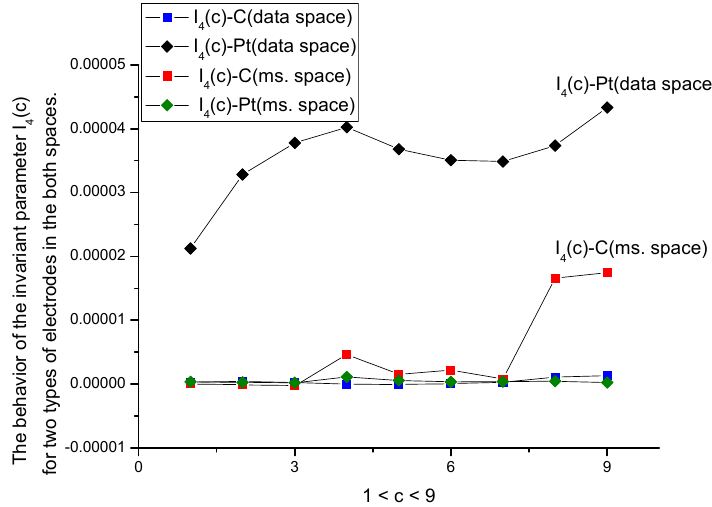
Figure 8. Behavior of the parameter I 4 ( c ) from Equation (A17). Having small values located in the interval 10 − 6 to 5 × 10 − 5 , it has a maximal sensitivity to the presence of an uncontrollable factor that can influence the interaction between the chosen electrode with D -tryptophan additive. The two curves below I 4 (c)-C (in data space) and I 4 (c)-Pt (in measurement space) do not have monotone characteristics. They are located in the interval 10 − 9 to 10 − 6 . Therefore, they appear as a couple of horizontal lines with values close to zero.